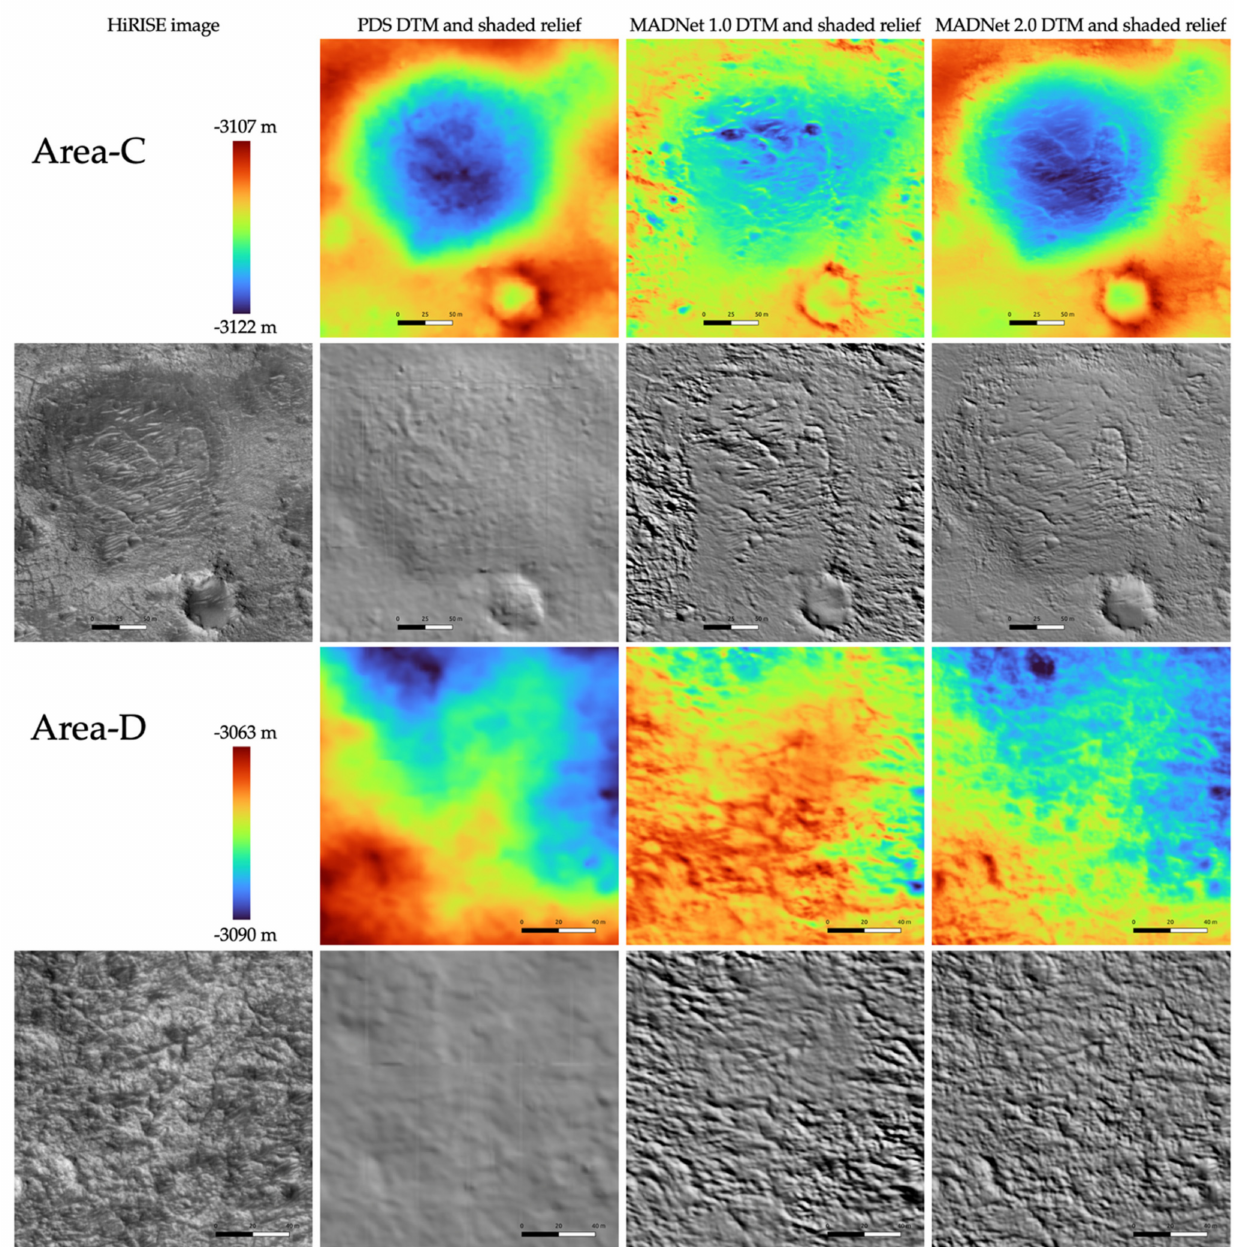
Figure 12. Examples of zoom-in views of the 1 m/pixel PDS HiRISE DTM, 50 cm/pixel MADNet 1.0 DTM, and 25 cm/pixel MADNet 2.0 DTM, produced from a single HiRISE image